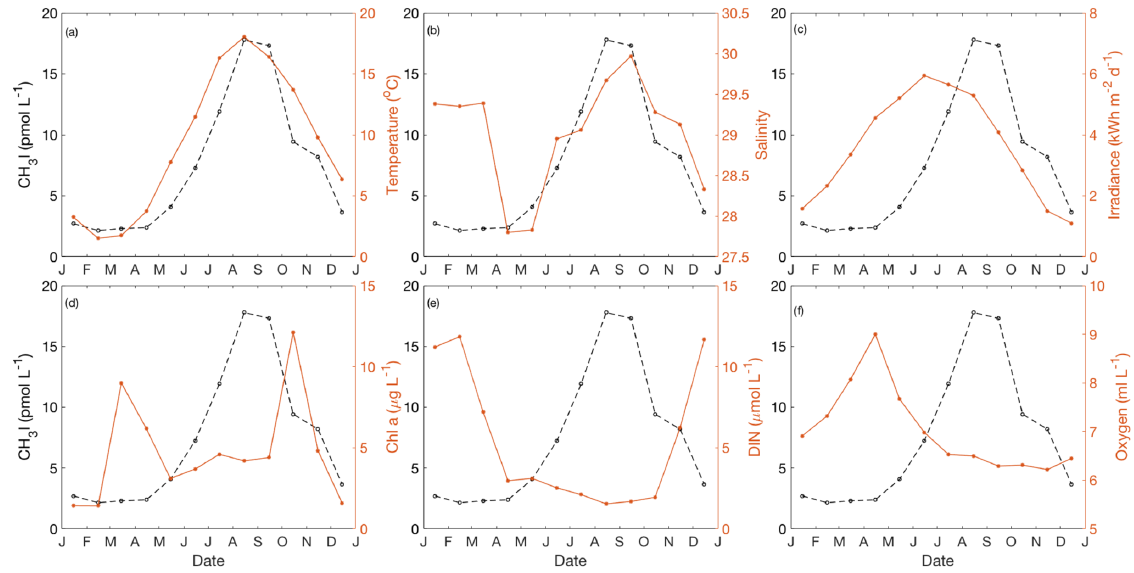
Figure 8. Annual cycle of (a) temperature, (b) salinity, (c) irradiance, (d) Chl a , (e) dissolved inorganic nitrogen (DIN) and (f) dissolved oxygen for near-surface water (1–5m) in Bedford Basin. The black dashed line depicts the annual cycle of CH 3 I. The figure presents the monthly mean values based on the data collected from May 2015 to December